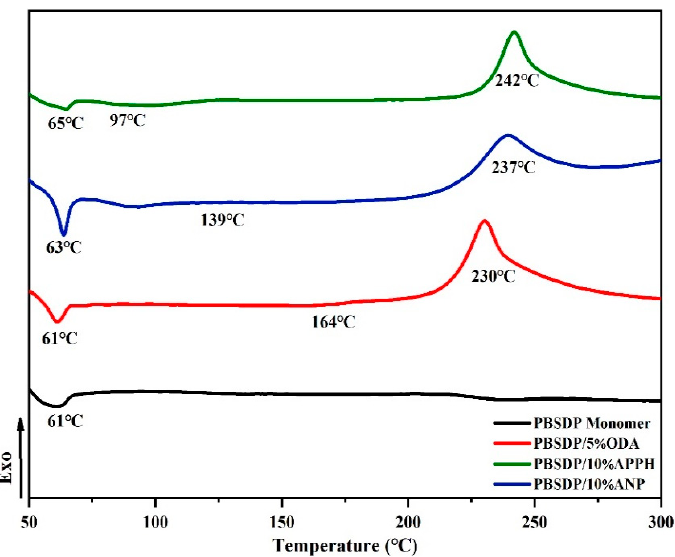
Figure 10. DSC of the DPTP monomer, DPTP-5%ODA mixture, DPTP-10%APPH mixture, and DPTP-10%ANP mixture.